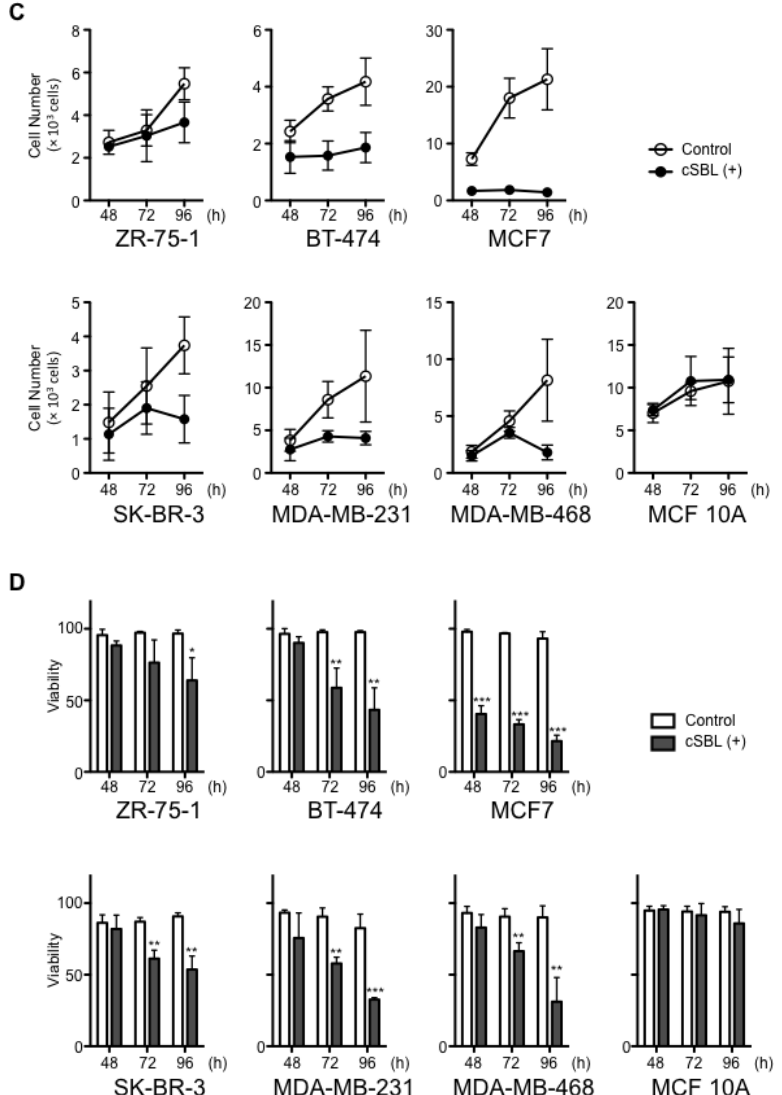
Figure 1. Anti-proliferative effects of R. catesbeiana sialic acid-binding lectin (cSBL) against breast cancer cell lines (ZR-75-1, BT-474, MCF7, SK-BR-3, MDA-MB-231, and MDA-MB-468) and a non-tumorigenic epithelial cell line (MCF 10A). ( A ) Viability of cells treated with cSBL. Cells were treated with cSBL (0.2–20 µ M) for 72 h. Each data point represents the mean ± SD of three independent WST-8 assays conducted in triplicate. ( B ) The effects of cSBL on the clonogenic potential of the cells. Colony assays were performed on the cells in the absence or presence of cSBL (1, 5, and 10 µ M) for 72 h followed by incubation in cSBL-free medium for 7–28 days. Then, the cells were fixed with 2% paraformaldehyde and stained with crystal violet. Representative images from three independent experiments are shown. Cell growth ( C ) and viability were determined by trypan blue assay ( D ) of the cells treated with or without cSBL. Cells were treated with cSBL (10 µM) for 48–96 h. Both live and dead cell numbers were counted by TC10. Each data point represents the mean ± SD of three independent assays. For both graphs, * p < 0.05. ** p < 0.01. *** p < 0.001.